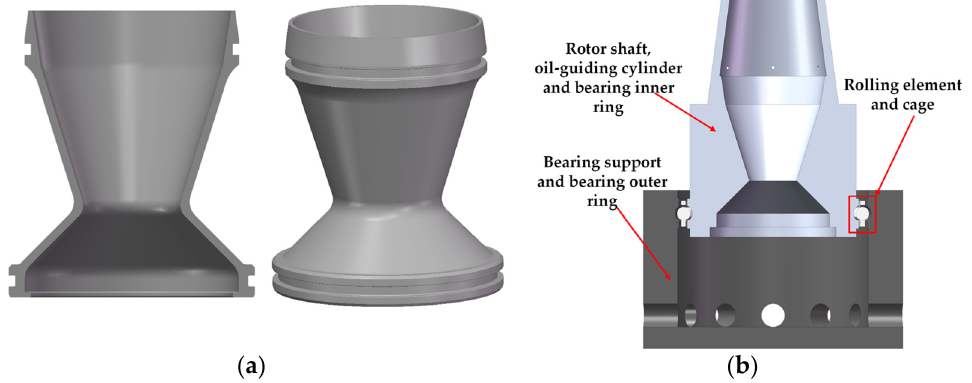
Figure 2. Three-dimensional modeling: ( a ) oil guide; ( b ) splash lubrication system.